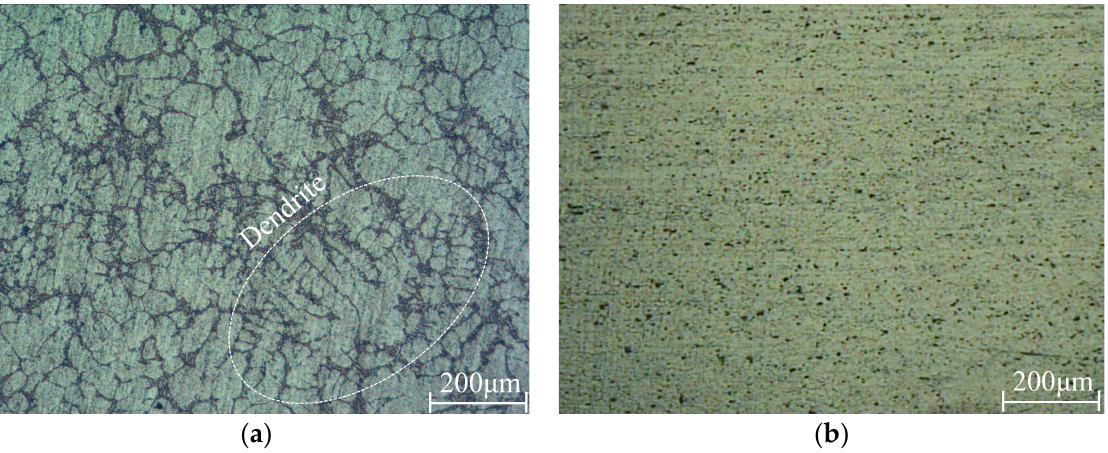
Figure 3. Microstructures of ingot: ( a ) A356; ( b ) A6061.